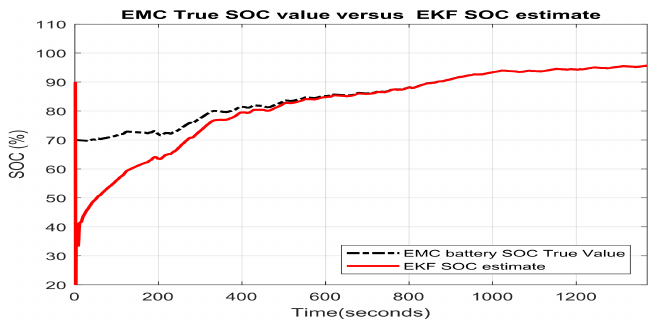
Figure 18. Robustness of EKF estimator for an increase in SOC initial condition value from 70 to